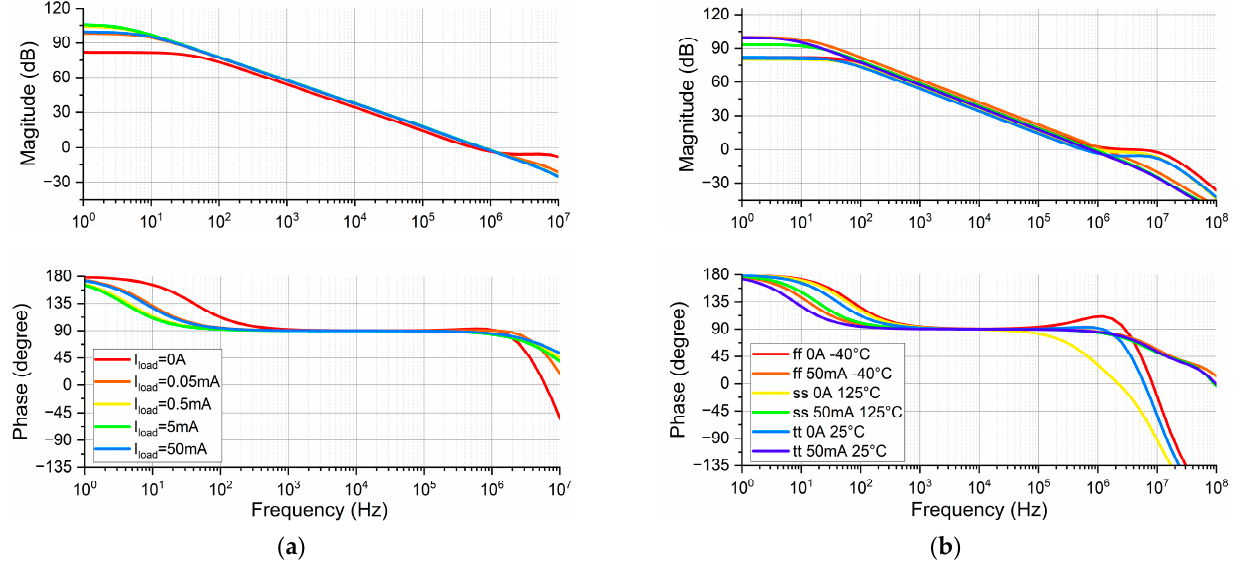
Figure 11. ( a ) Simulated amplitude-frequency and phase-frequency curves under different load current with C L = 50 pF. ( b ) Simulated amplitude-frequency and phase-frequency curves under different load current, temperature, and process corner with CL = 50 pF.